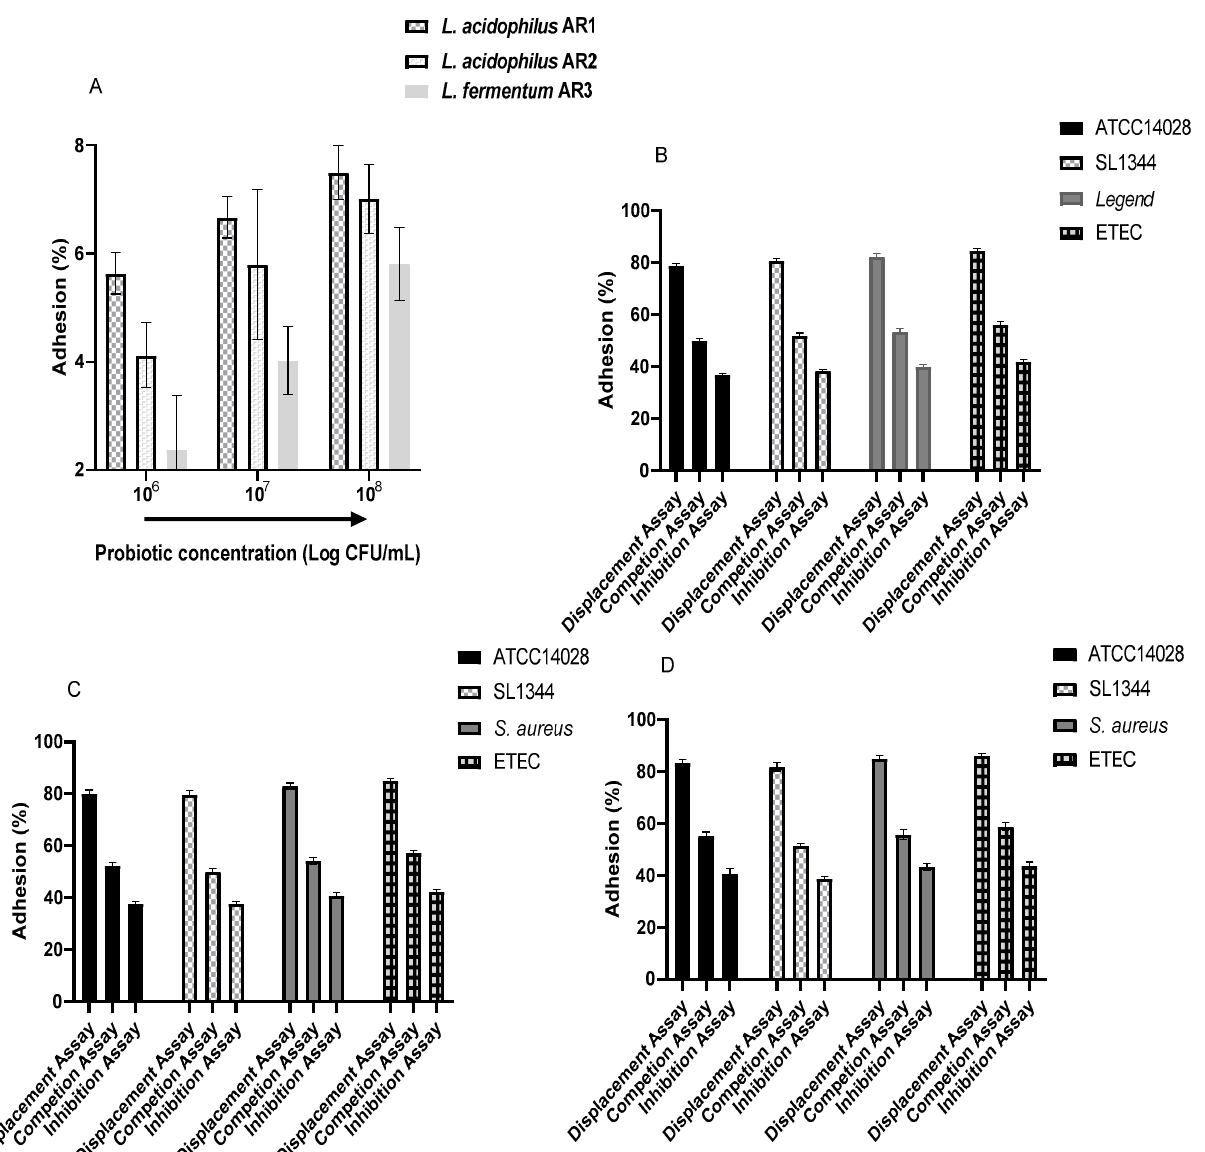
Figure 13. Adhesion of Lactobacilli with MODE-K cells ( A ) and inhibitory effects on the adhesion of different pathogenic with MODE-K cells by L. acidophilus AR1 ( B ), L. acidophilus AR2 ( D ), and L. fermentum AR3 ( C